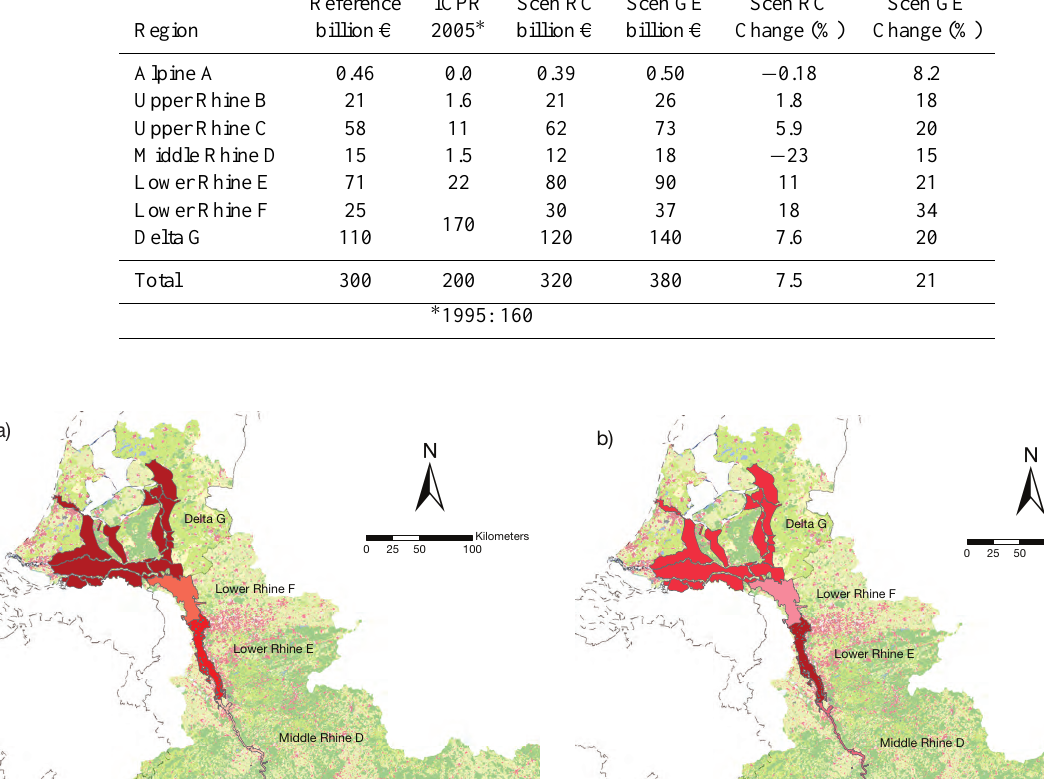
Results of expected damage per land-use class for the entire Rhine basin are presented in Table 5. The potential damage of residential and commercial areas in the Rhine basin is 200 billion C, which comprises 63% of the total damage, and is projected to increase to 260 billion C (RC) and 320 billion C (GE) (Table 5). Agriculture, cultivation and pasture comprise 93 billion C damage (29% of the total damage), which is projected to decrease to 61 billion C (RC) and 63 billion C